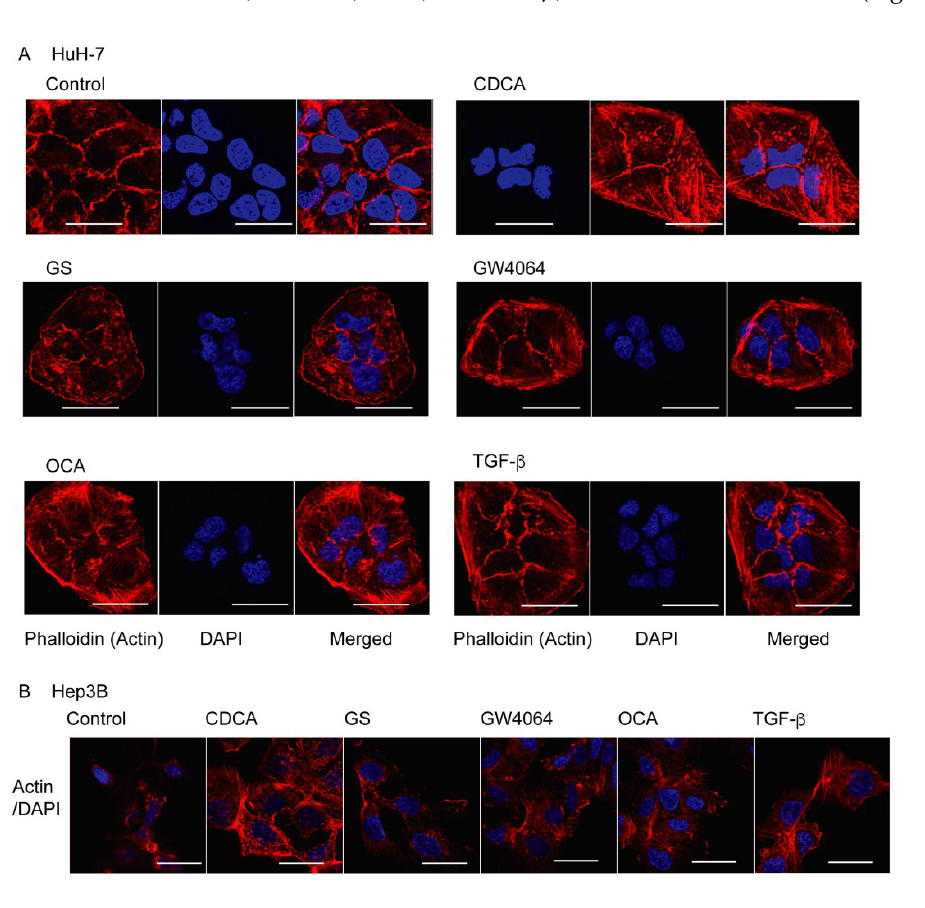
Figure 1. Farnesoid X receptor (FXR) activation induces actin polymerization in HuH-7 cells ( A ) and Hep3B cells ( B ). Cells were treated with vehicle control (Control), 100 μM chenodeoxycholic acid (CDCA), 32 μM guggulsterone (GS), 10 μM GW4064, 10 μM obeticholic acid (OCA), or 10 ng/mL transforming growth factor β (TGF-β) for 48 h and stained with rhodamine phalloidin ( red ) to detect actin polymerization and with DAPI ( blue ) to show nuclei. Scale bar, 50 μm.